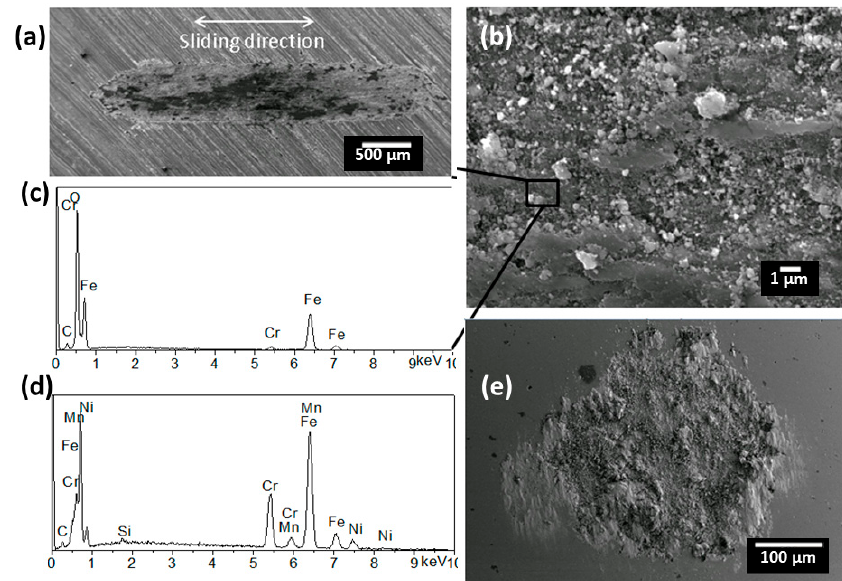
Figure 9. Wear track of 304SS under ( a ) low magnification and ( b ) high magnification; ( c ) EDS analysis of area in image ( b ); ( d ) area EDS analysis of as-received bare 304SS substrate; ( e ) wear scar of counterpart Al 2 O 3 ball.